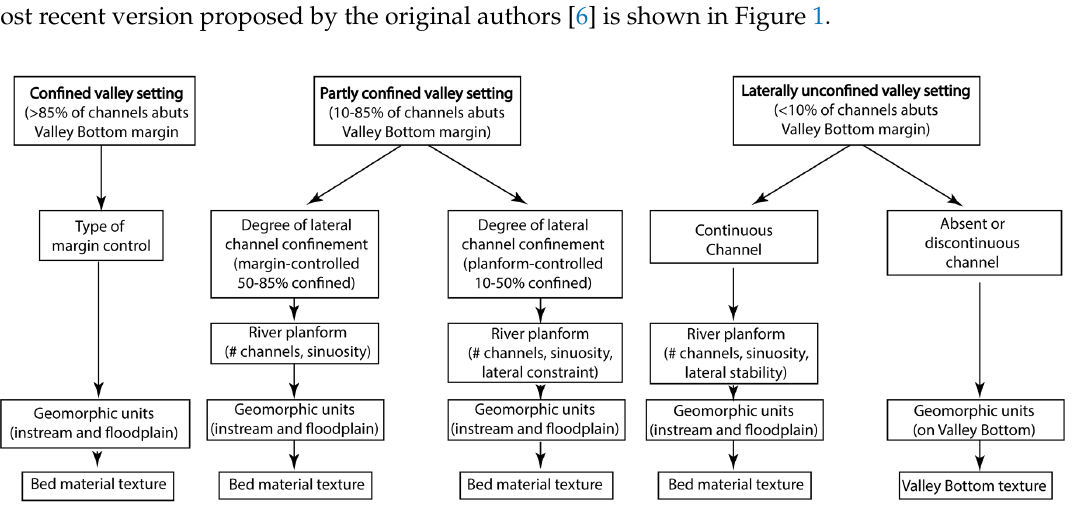
Figure 1. The original River Styles procedural tree (Source: Modified from Fryirs and Brierley [6]; permission automatically granted by the journal policy).